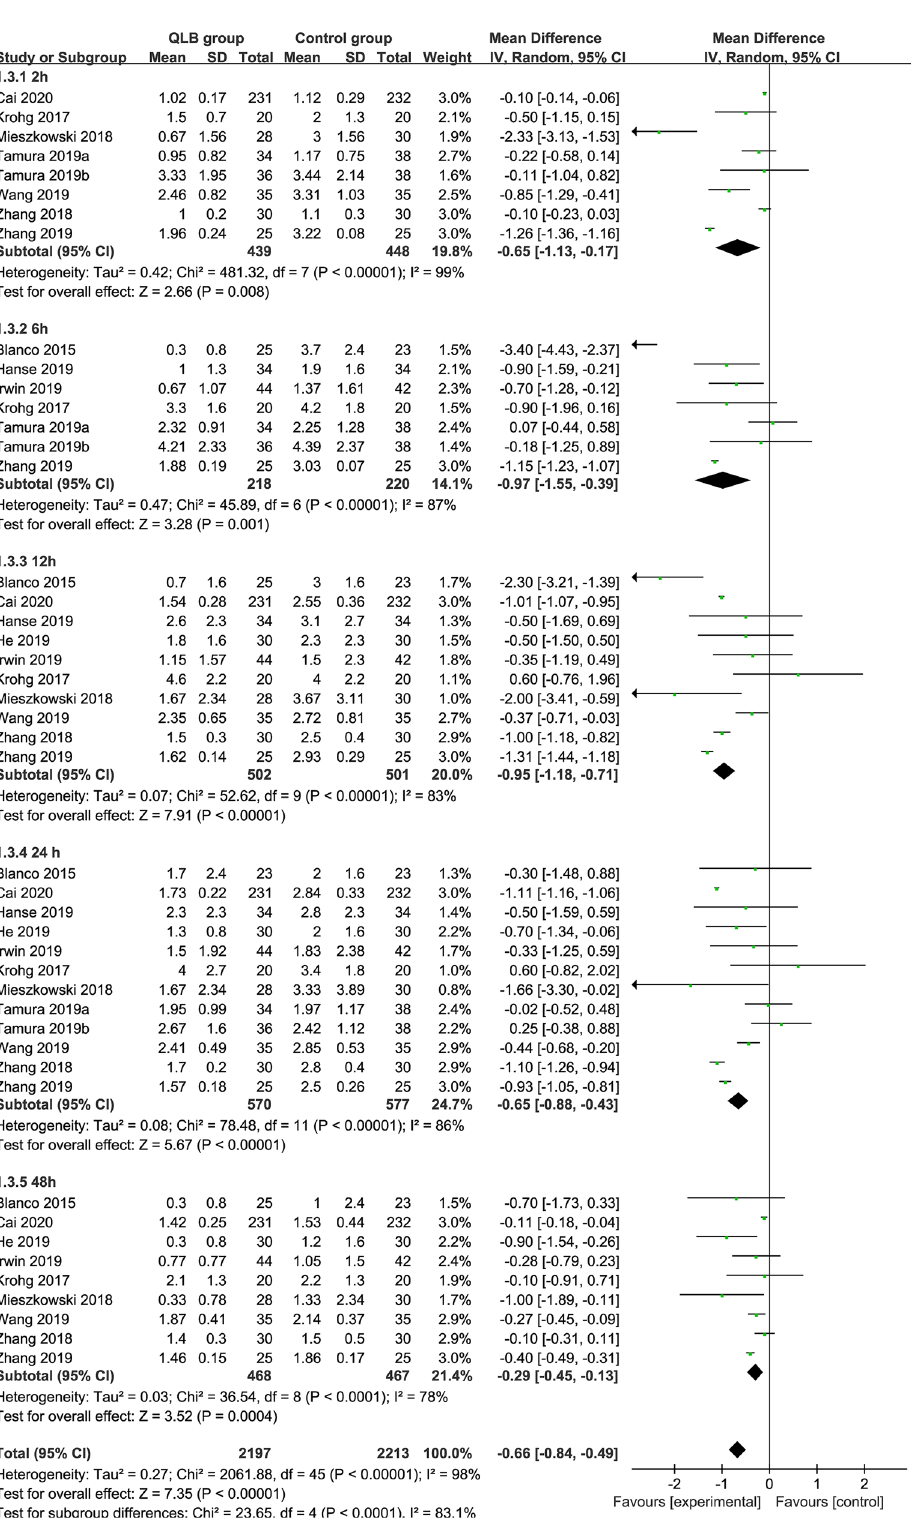
Figure 5. Forest plots of pain scores at rest at different time points after surgery at